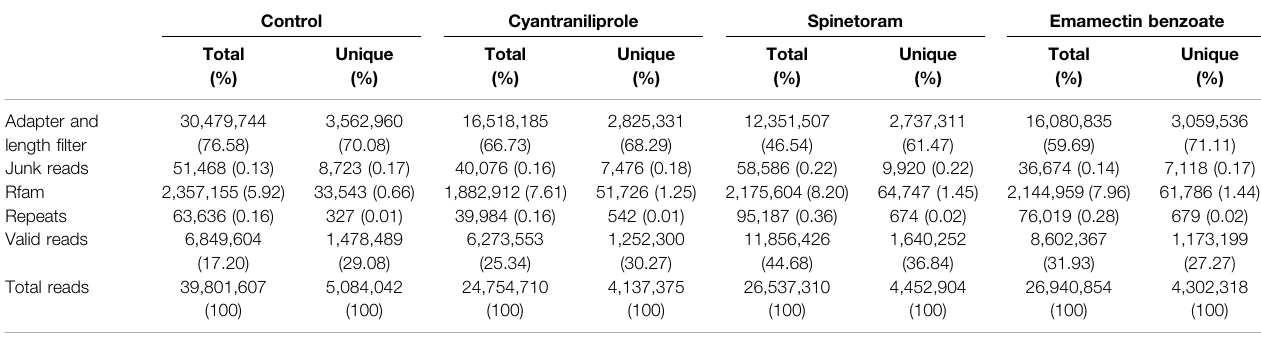
TABLE 2 | Summary of small RNA sequencing.